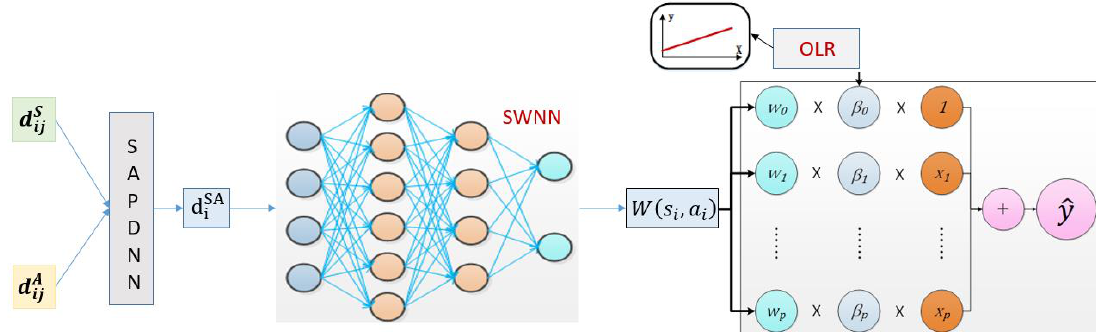
Figure 4. The modeling process of SANNWR.